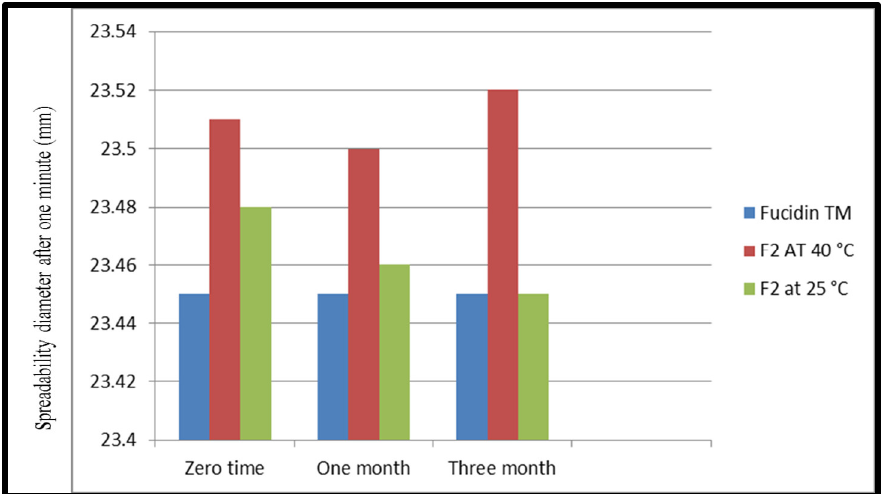
Figure 1. Spreadability values for F2 and fucidinTM at zero time, 1 month, and after 3 months at 25 °C and accelerated conditions (40 ± 2 °C/75% ± 5% RH).